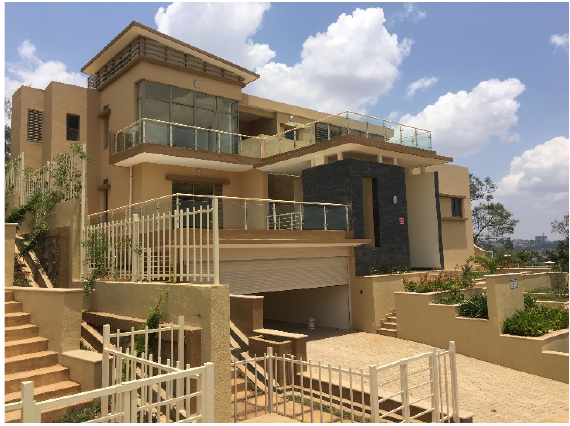
Figure 51. The Umudugudu Kigali Vision: 5-bedrooms Villa, back yard. Photograph by Manlio Michieletto.